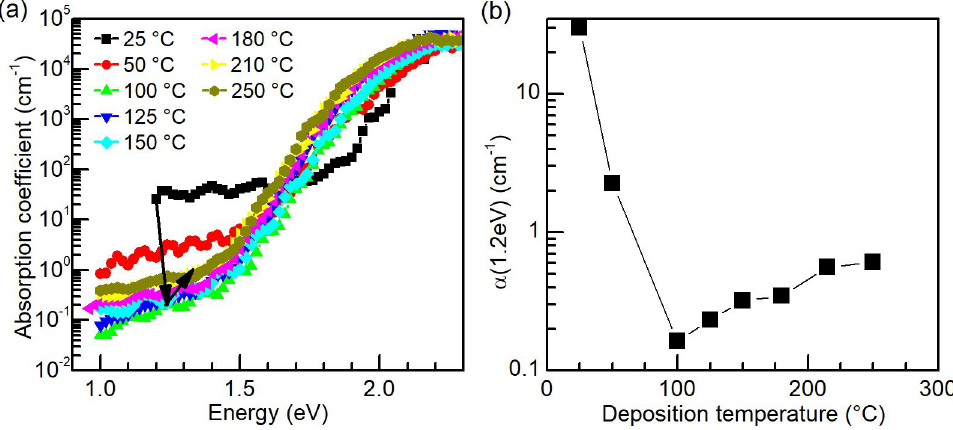
Figure 3. ( a ) Constant photocurrent measurement (CPM) measurement of mid-gap absorption of a-Si:H films deposited at various temperatures in the range of 25 ◦ C to 250 ◦ C; and ( b ) the dependence of the absorption coefficient α on the deposition temperature. The lines between the points are drawn to guide the eye.